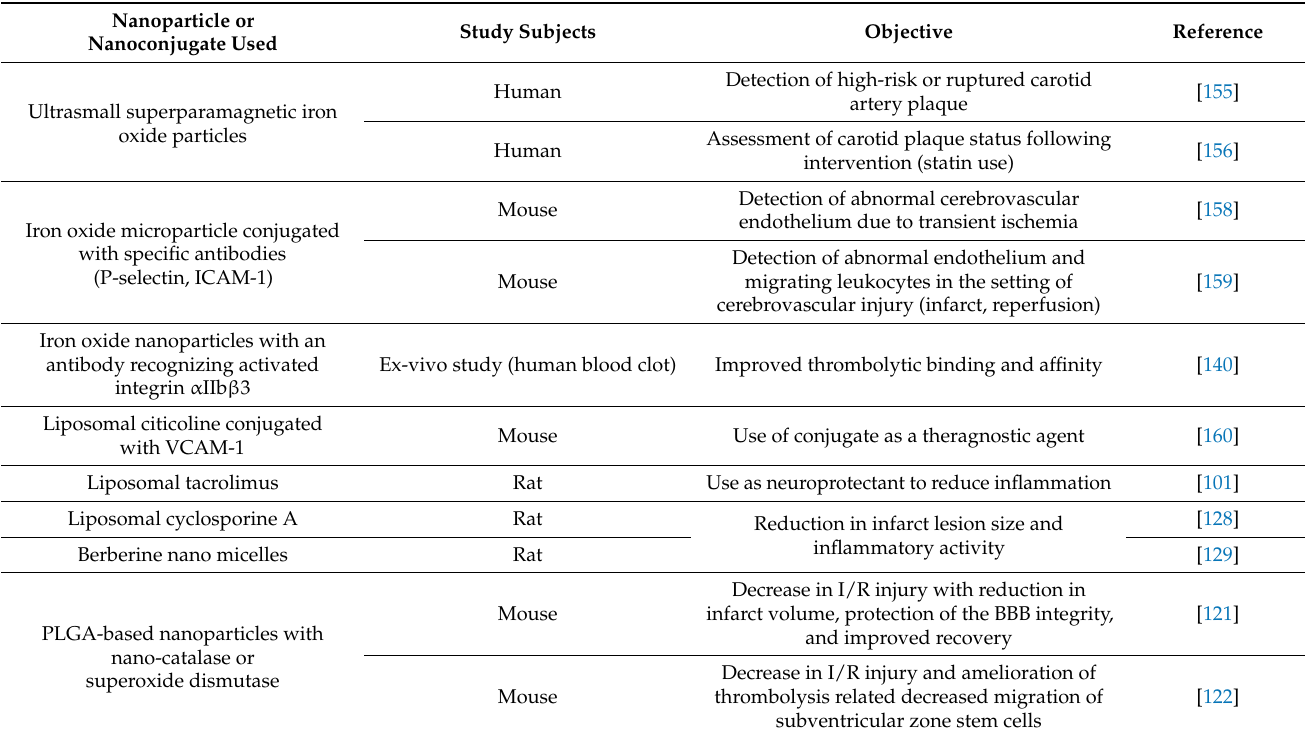
Table 1. Nanoparticles and nanoconjugates investigated for potential applications in ischemic stroke diagnosis, treatment, and study of cerebrovascular